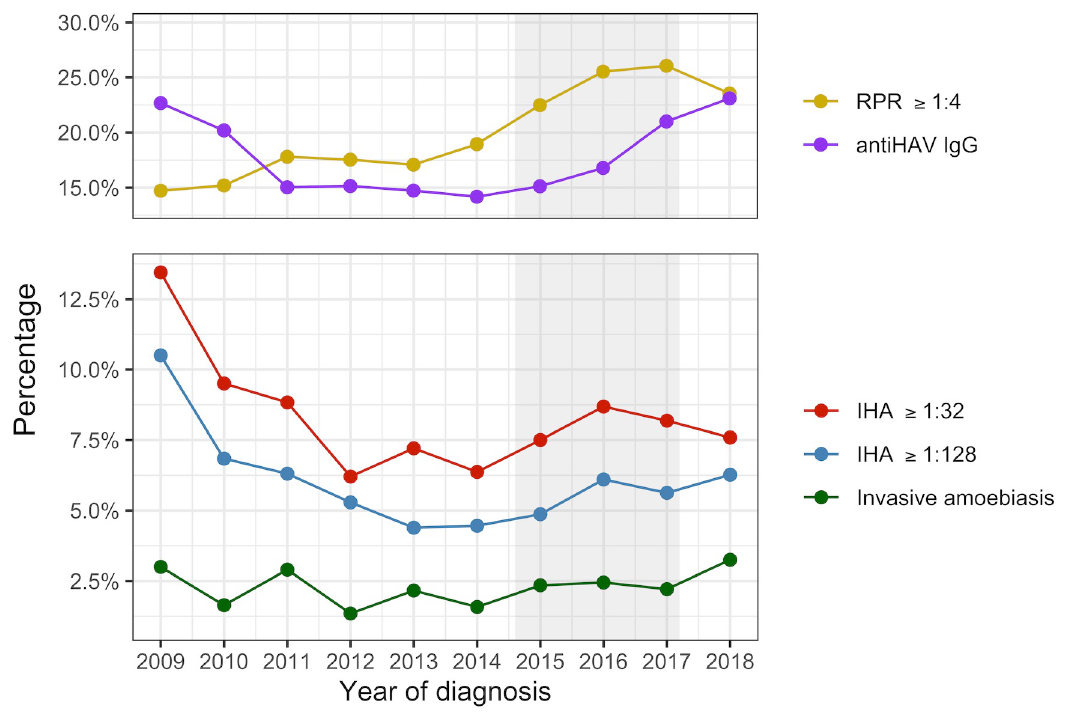
Fig 3. Trends of prevalence of invasive amoebiasis and seroprevalences of Entamoeba histolytica , hepatitis A virus (HAV), and syphilis among newly diagnosed people living with HIV from 2009 to 2018. The grey shade indicates the outbreak of acute hepatitis A in Taiwan from mid-2015 to 2017. The prevalence of invasive amoebiasis was calculated from all newly diagnosed people living with HIV, while the seroprevalences of amoebiasis, HAV and syphilis were calculated from 3499, 4601, and 5308 patients with indirect hemagglutination assay, anti-HAV immunoglobin G (IgG), and rapid plasma reagin (RPR) determined at baseline, respectively. An HAV vaccination campaign was started since late-2015. Serum anti-HAV IgG levels were measured routinely before vaccination and pre-vaccination anti-HAV IgG measurements were used in the